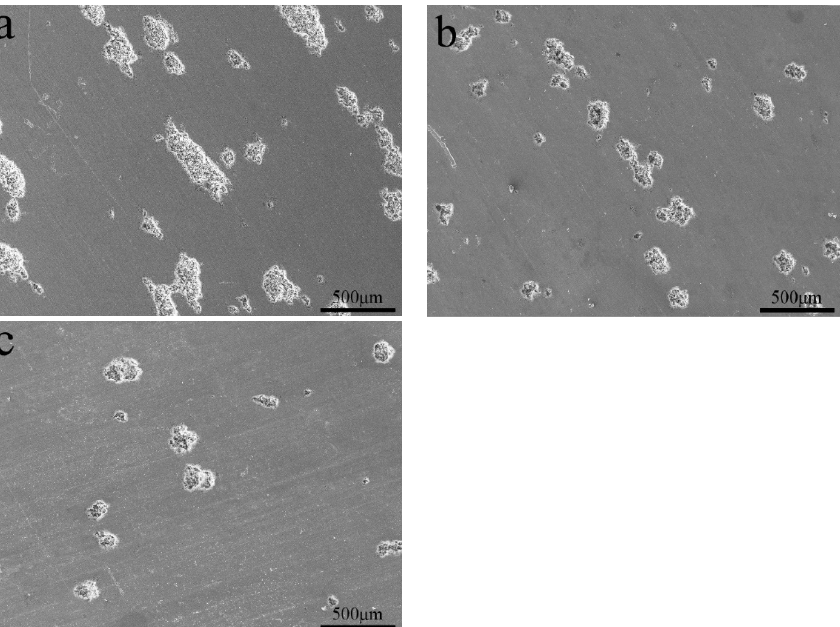
Figure 9. SEM images of corrosion surface of the foil alloys: ( a ) Al-0.2Fe-0.06Cu; ( b ) Al-0.2Fe-0.06Cu- 0.1La; ( c ) Al-0.2Fe-0.06Cu-0.15La.